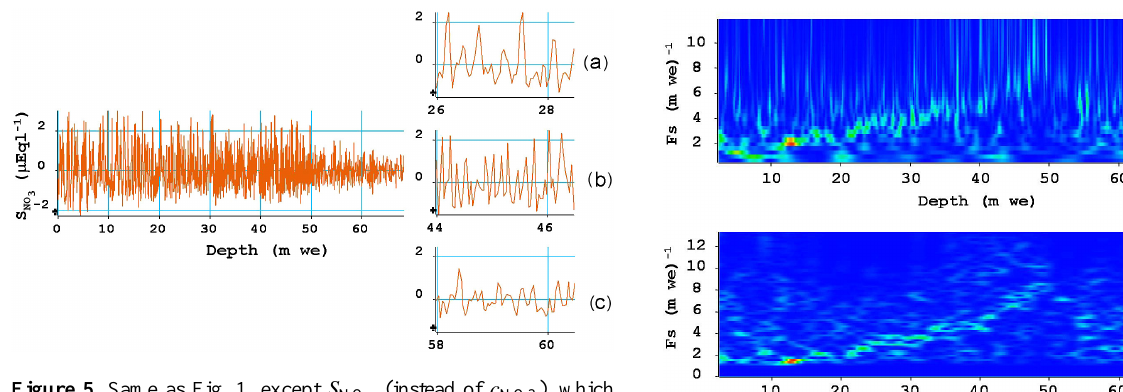
(instead of c NO3 ), which Figure 5. Same as Fig. 1, except S NO 3 correspond to reprocessed nitrate concentration after thresholding, spline interpolation, and mean value removal. Figure 6. Scalogram (top) and spectrogram (bottom) of NO 3 con- centration depth profiles as a function of depth in mwe and spa- tial frequencies f s (( m we ) − 1 ) . The colour scale (from blue to red) shows increasing energy of the